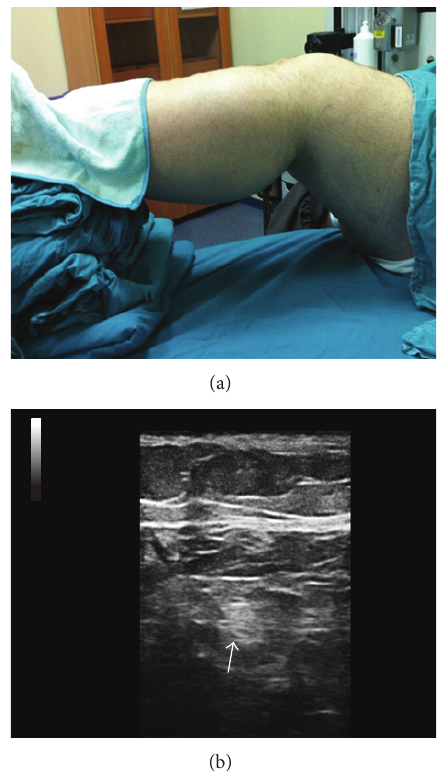
Figure 1: (a) Positioning for popliteal approach to the tibial nerve block. (b) Transverse sonogram in the popliteal region showing the tibial nerve as a hyperechoic nodule (arrow).